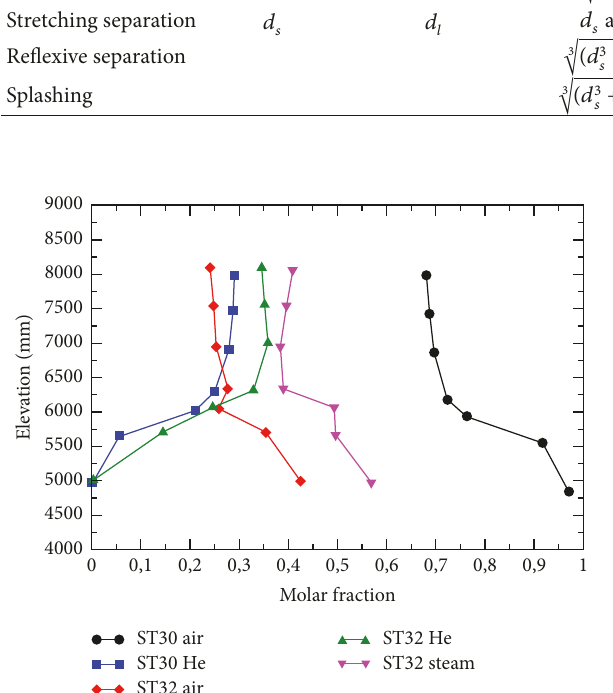
Figure 19: Initial molar fraction in the stratified zone in Vessel-1.